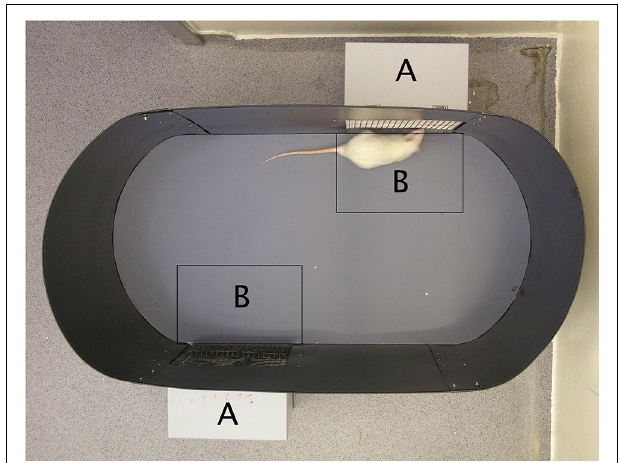
FIGURE 7 | A photograph of the sexual incentive motivation test arena. The incentive animal cages (marked with an A on the photograph) are located on the outside of the oval arena (100 × 50 cm). They are detachable from the outside of the wall so that the position of the incentive animals can be changed randomly. The side facing the arena is made of a wire mesh that allows the experimental subject to see, smell and hear the incentives. A virtual zone of 21 × 29 cm (marked with a B on the photograph) is defined outside each incentive animal cage. A computerized videotrack system determines the experimental subject’s position, the time spent in the incentive zones, the number of visits to them, the distance moved during the test, the mean speed of movement while moving, and the immobility time. Reproduced from Spiteri and Ågmo (2006). Copyright 2006, republished with permission from